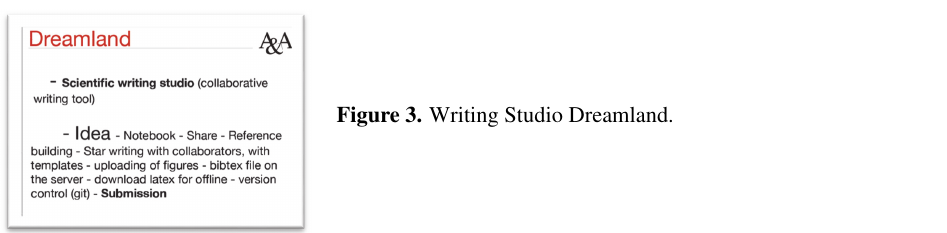
Figure 3. Writing Studio Dreamland.